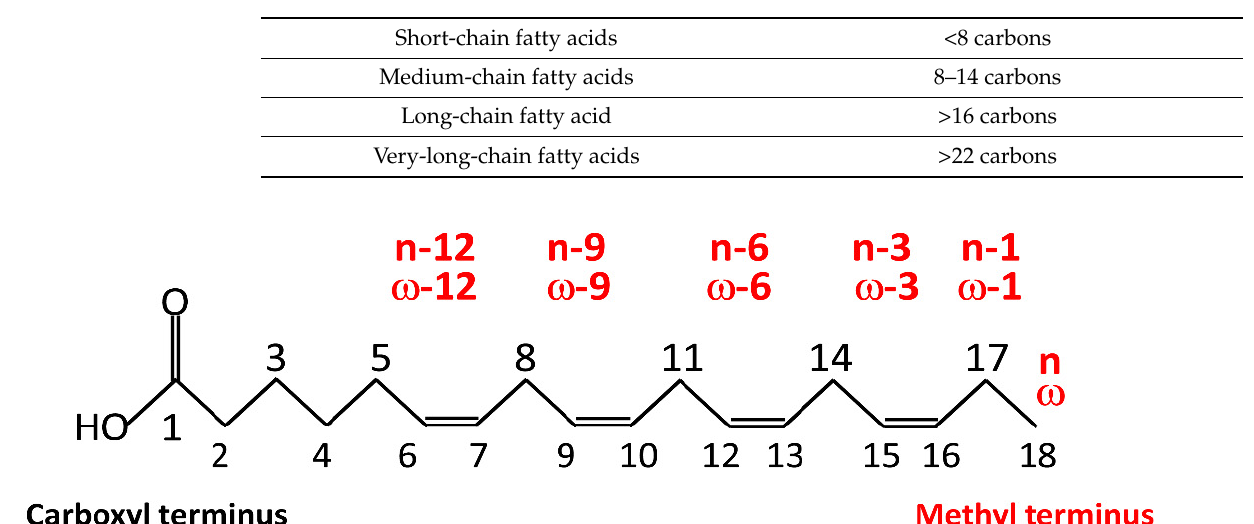
Table 1. Classification of fatty acids based on the length of the hydrocarbon chain.